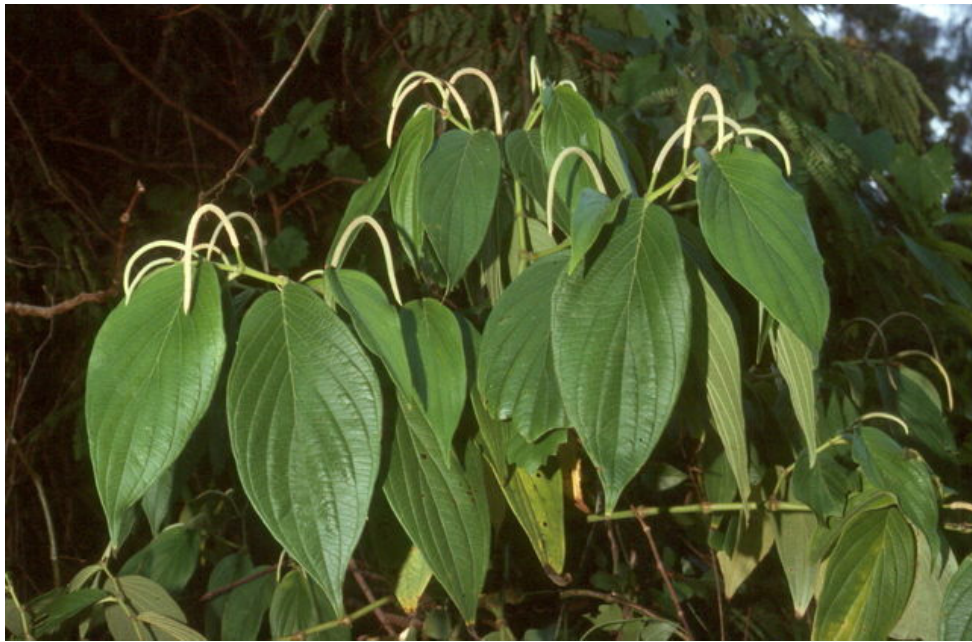
Figure 1. Photograph of Piper aduncum L. (© Copyright Bobby Hattaway, 2011 [10]).